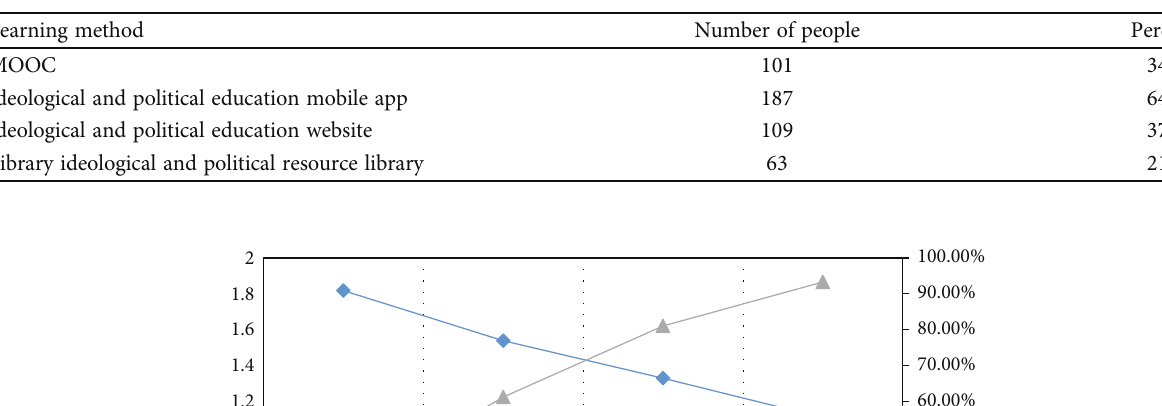
Table 1: Which way respondents prefer to study.